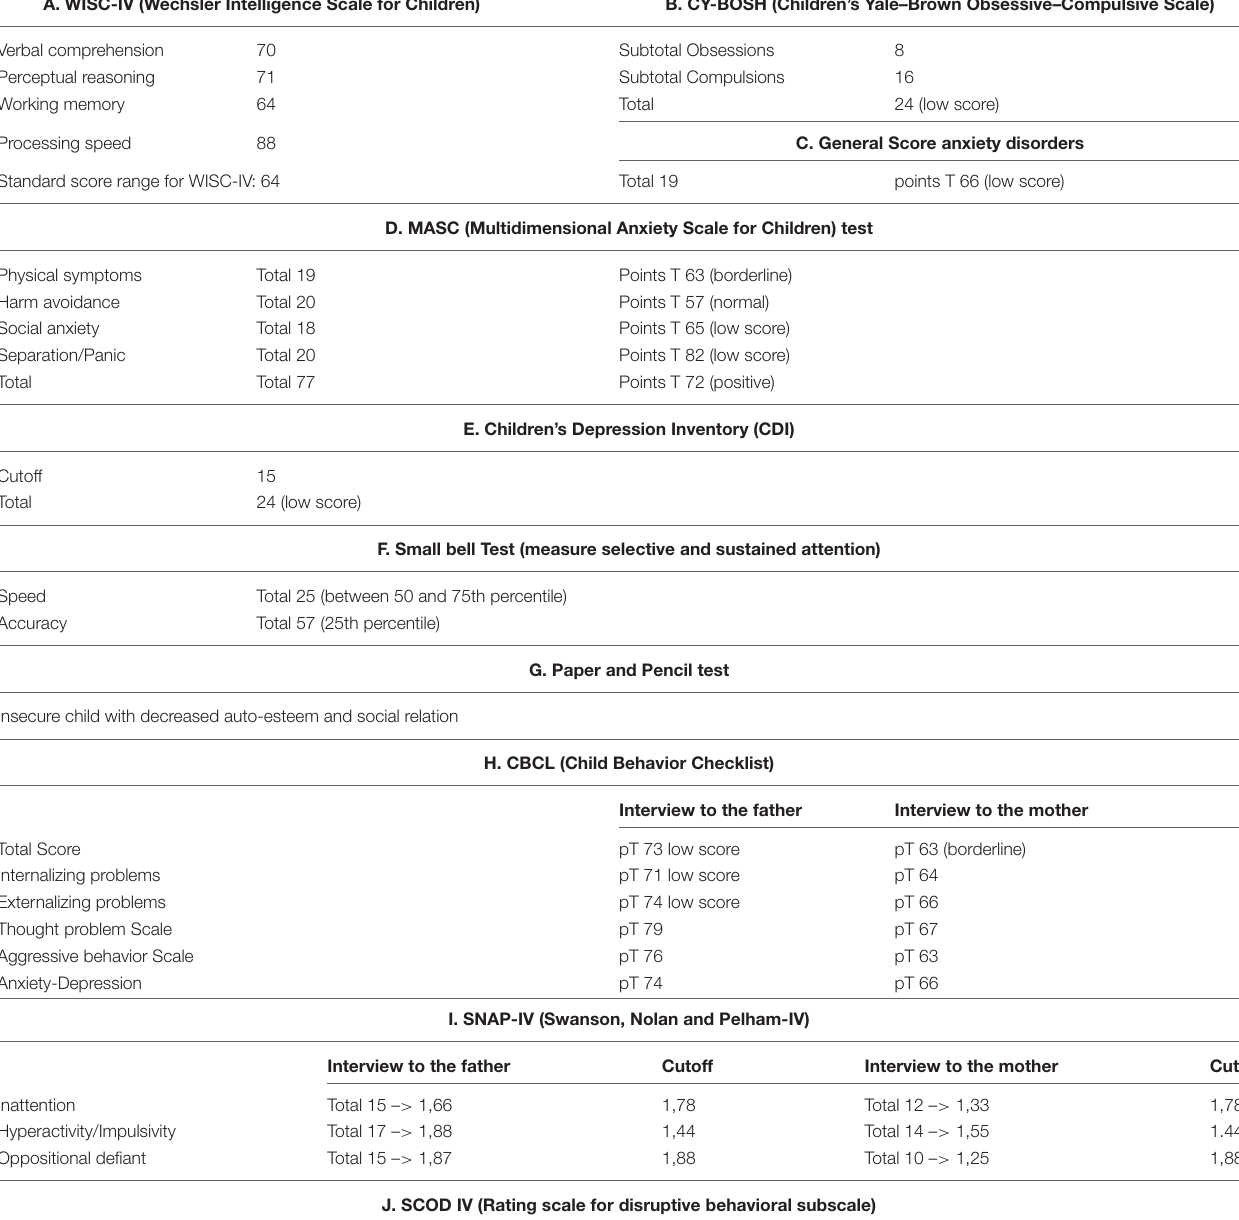
TABLE 1 | (A–J). Neuropsychological assessment of proband (A–G) and both parents